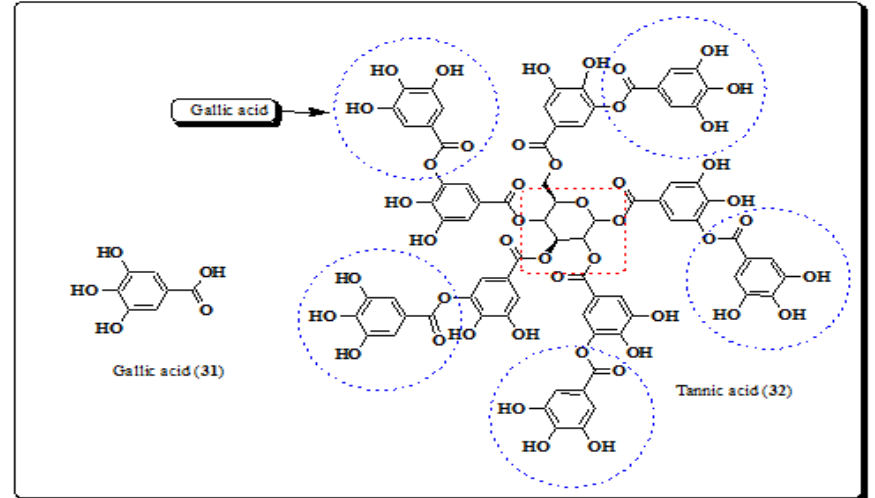
Figure 4. Structures of polyphenolic compounds from E. laevis. ( 31 , 32 )